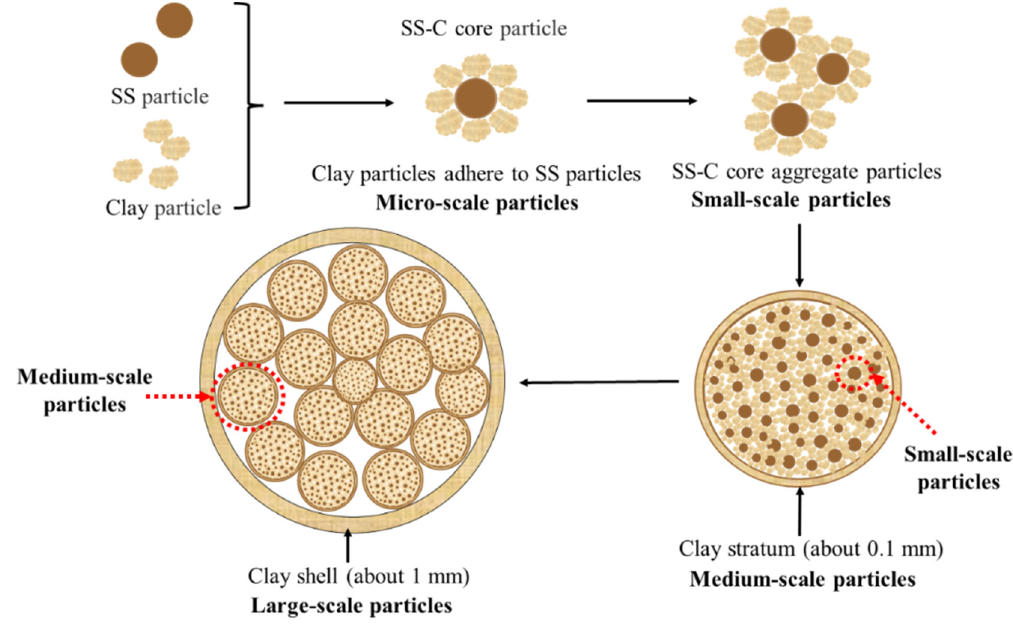
Figure 4. Schematic structure of sewage sludge-clay multiscale composite particles (SS-C composite particles).